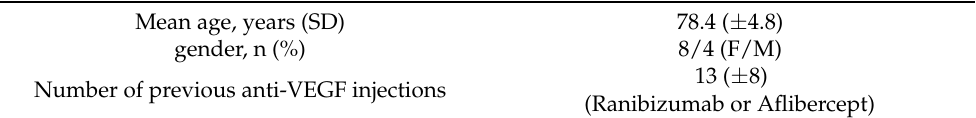
Table 1. Characteristics of the population of study and details before the Brolucizumab injection.